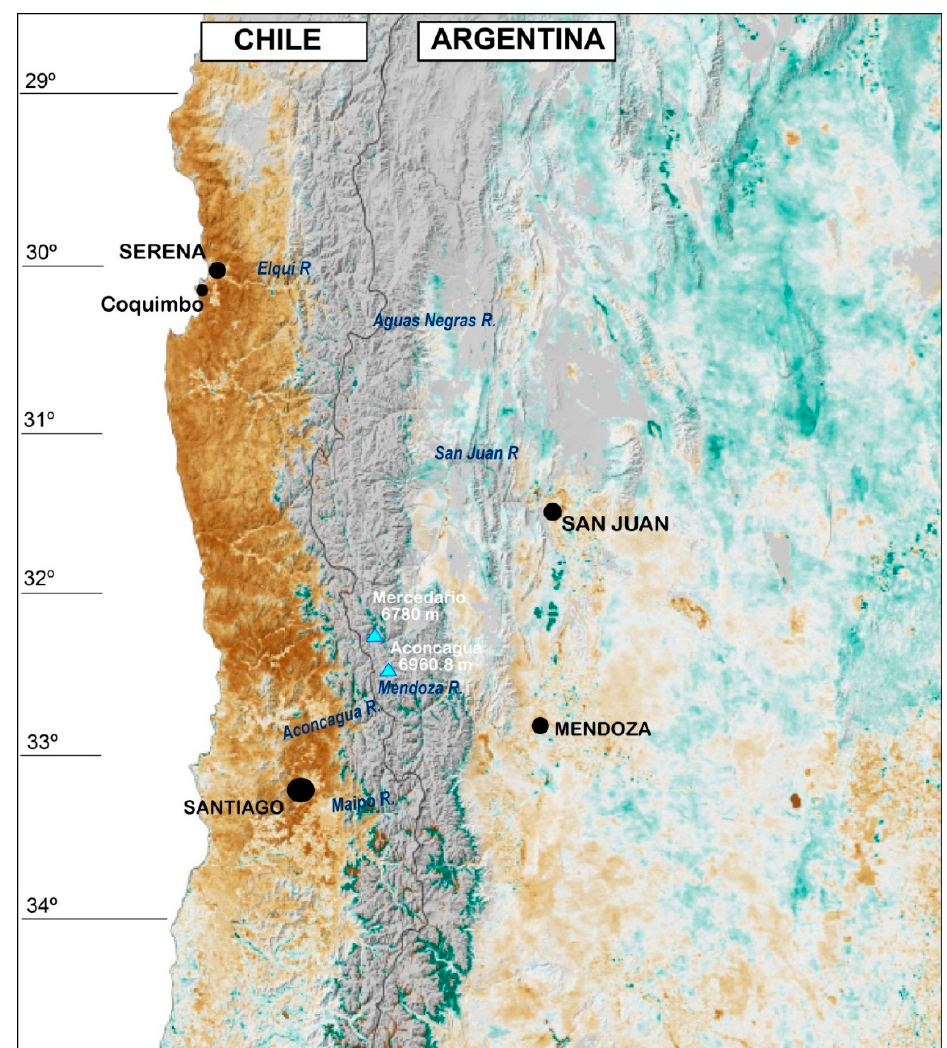
Figure 2. Image taken from NASA Earth Observatory contrasting vegetation health during the 2000–2010 period by Normalized Difference Vegetation Index (NDVI) [38]. Brown indicates vegetation that is less abundant and healthy than normal for this time. Gray highlights snowy and icy areas, or those with minimal vegetation. Green corresponds to abundant vegetation areas in valleys near glaciers and snow cover. The map was done by Lauren Dauphin, using MODIS data from NASA EOSDIS/LANCE and GIBS/Worldview and topographic data from the Shuttle Radar Topography Mission (SRTM).